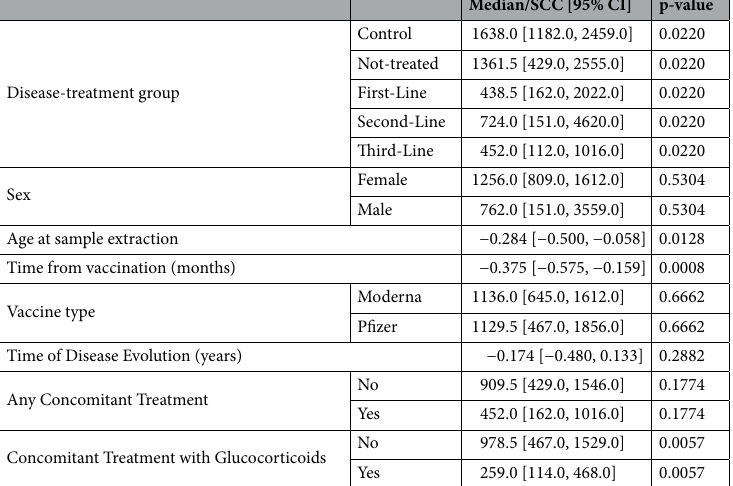
Table 2. Univariate association of neutralizing antibody (nAB) levels after SARS-CoV-2 vaccination with Disease/Treatment status and demographic and clinical parameters. Association with continuous variables are estimated using Spearman Correlation Coefficients (SCC). Categorical variables, antibody levels are summarized using group medians. Range between brackets correspond to 95% confidence intervals computed with 1.000 boostrap resamples. p-values are derived from the associated SCC for continuous variables, while a Mann–Whitney (binary) or a Kruskal test (Disease/Treatment group) were used for categorical variables. SCC: Spearman Correlation Coefficient; 95% CI: 95% confidence interval.